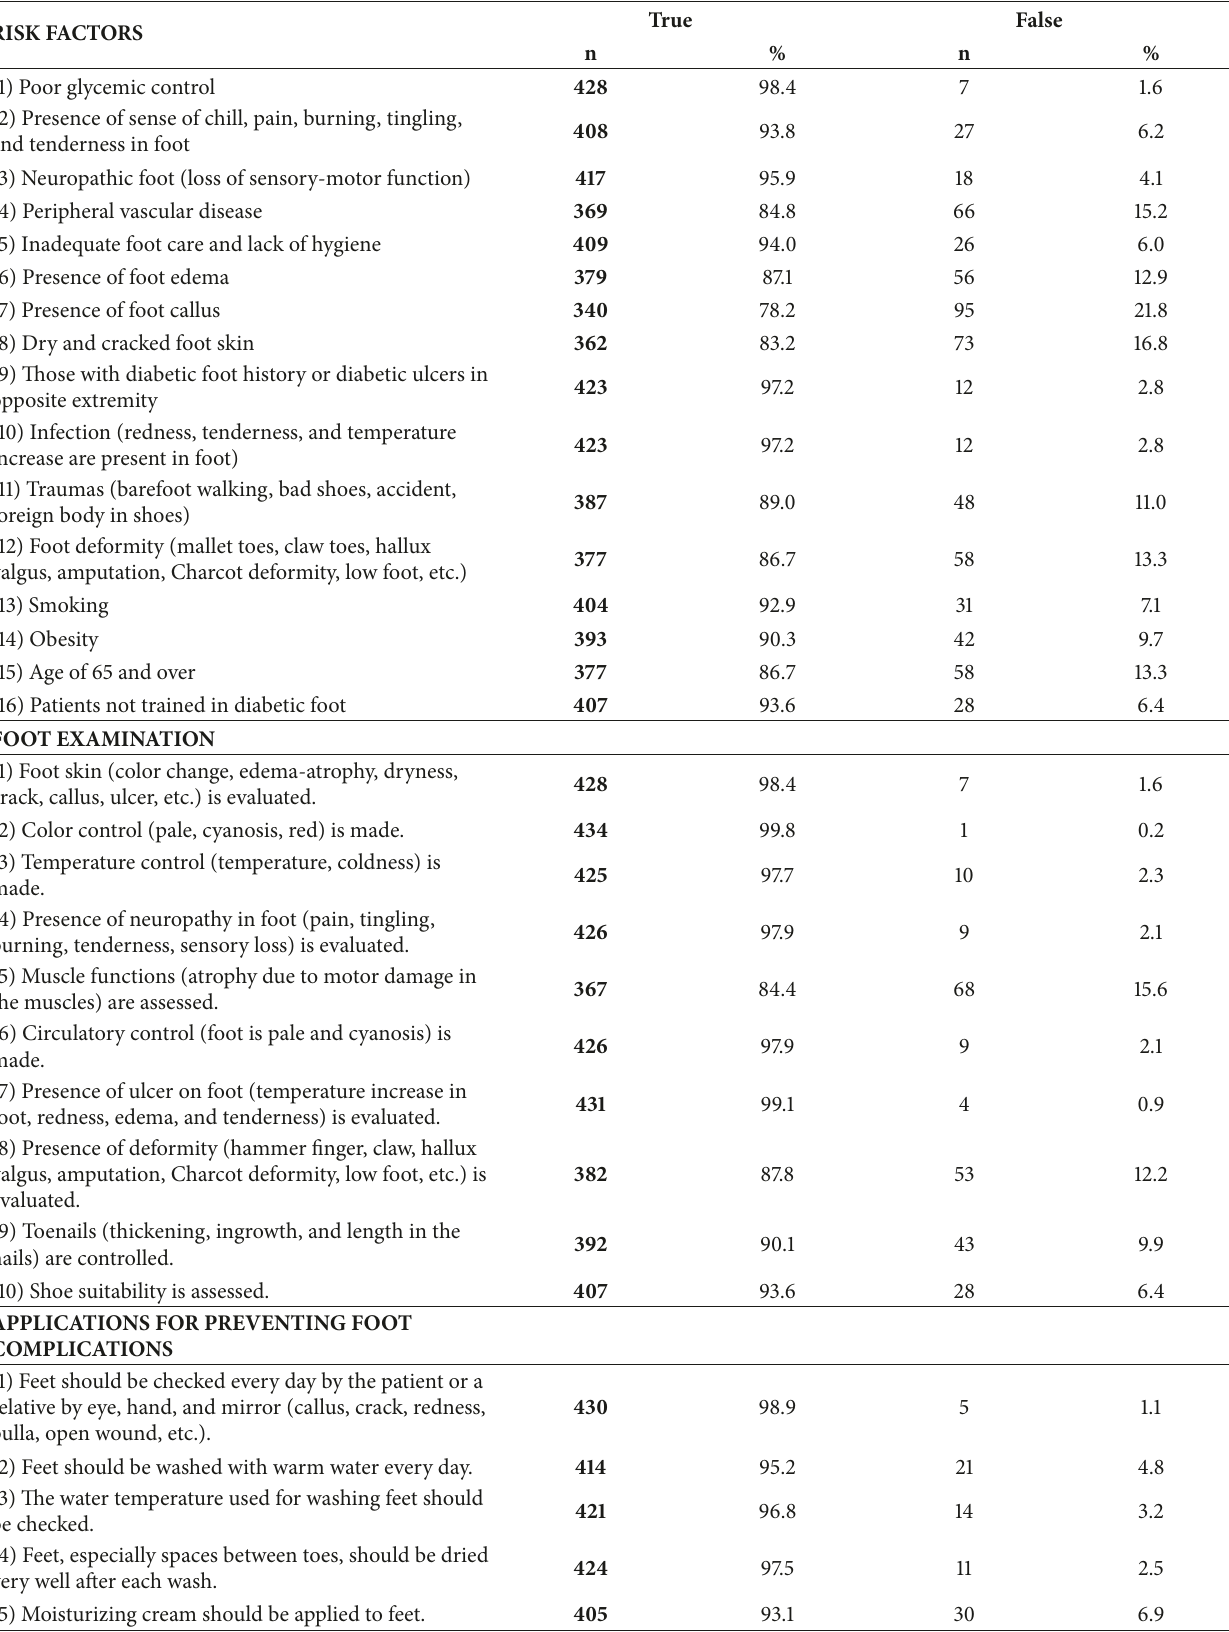
Table 4: Nurses’ Knowledge Level Form on Diabetic Foot